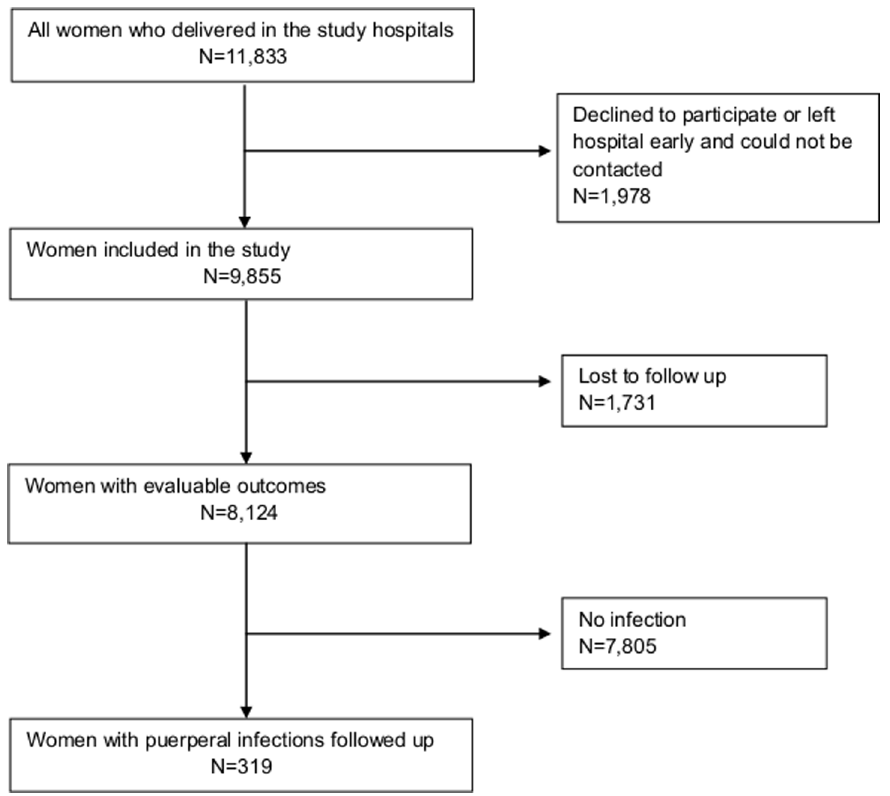
Figure 1. CONSORT diagram illustrating follow up of study population.